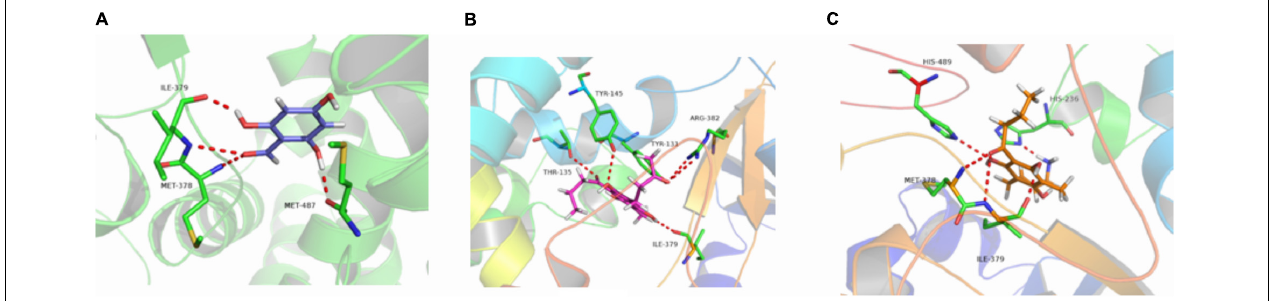
product, which was purified by column chromatography with EtOAc/petroleum (1/3) to obtain d and